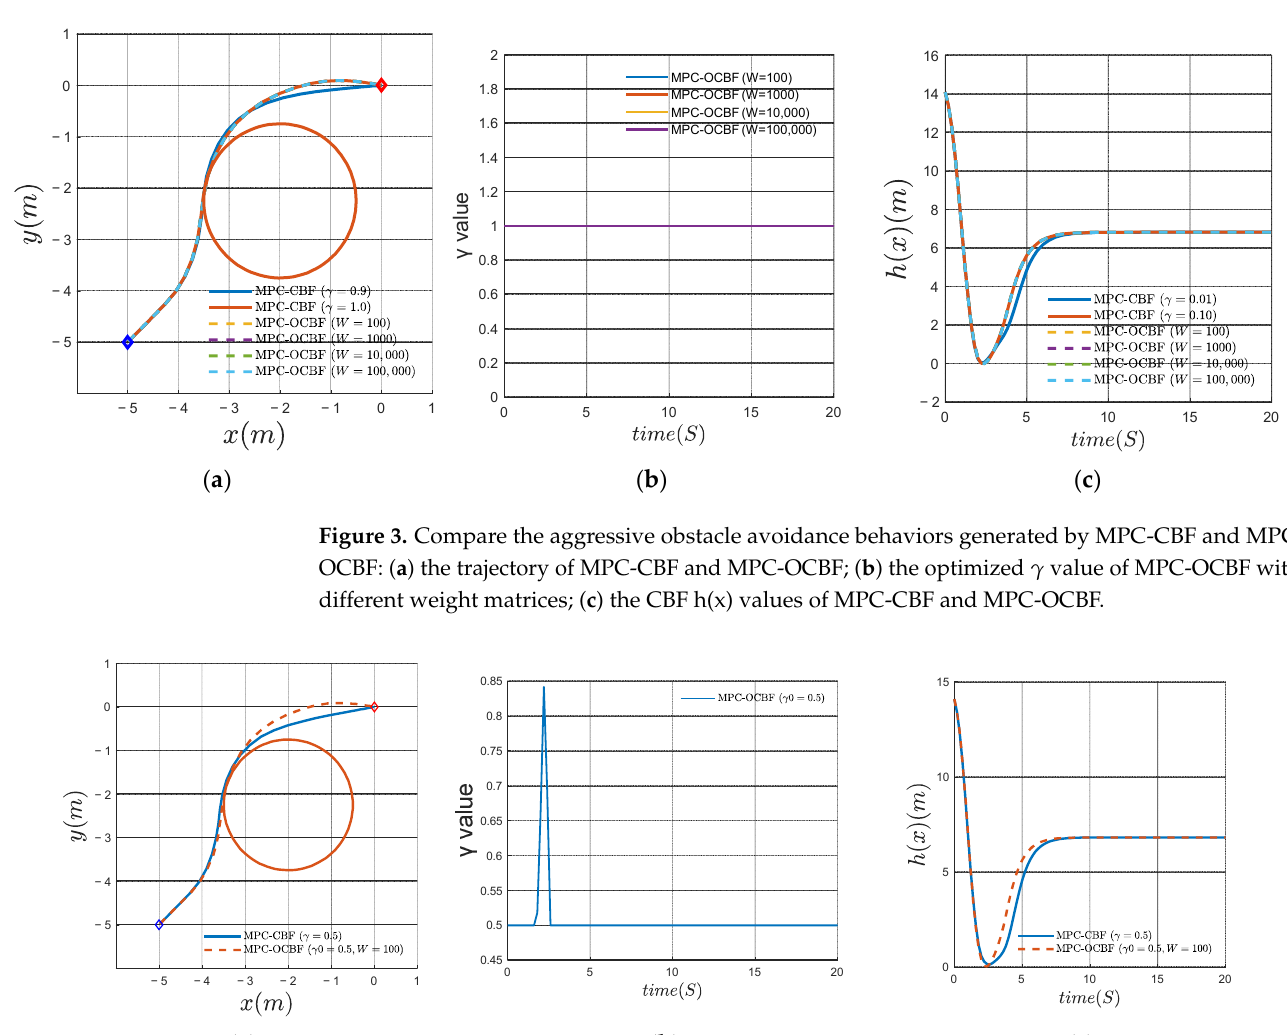
. . The results are illustrated in Figure 4. Figure 4. Compare the user-defined obstacle avoidance behaviors generated by MPC-CBF and MPC-OCBF: ( a ) the trajectory of MPC-CBF and MPC-OCBF; ( b ) the optimized γ value of MPC-OCBF; ( c ) the CBF h(x) values of MPC-CBF and MPC-OCBF.